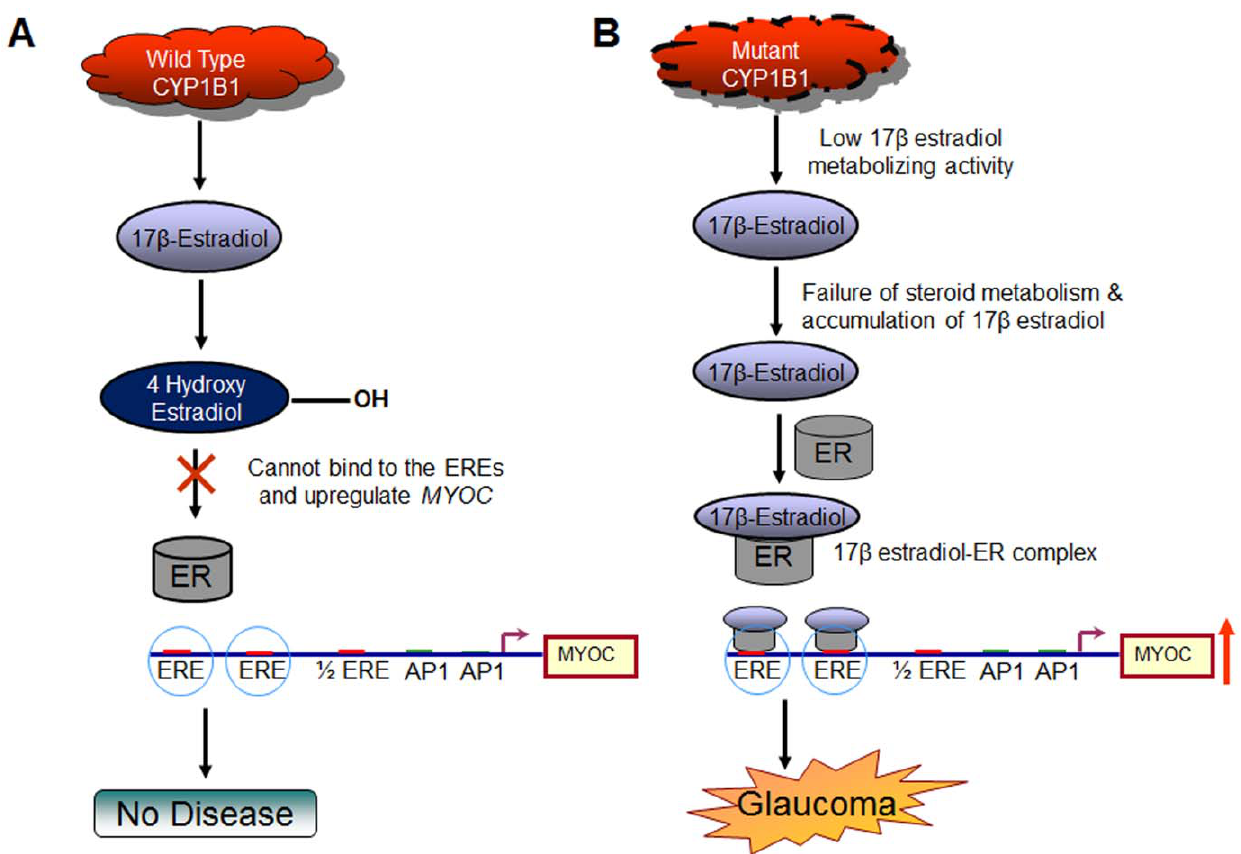
Figure 9. Schematic diagram showing potential influence of CYP1B1 mutants on MYOC expression. In PanelA fully functional wild-type CYP1B1 metabolizes 17 b -Estradiol; thus limiting the steroid to form the hormone-receptor complex (17 b -Estradiol-ER) whereas in PanelB restricted CYP1B1 enzymatic activity results in higher levels of the steroid available for formation of 17 b -Estradiol-ER complex which in turn leads to MYOC upregulation through estrogen response elements (EREs) in MYOC promoter. The latter condition might have a potential implication in glaucoma pathogenesis.